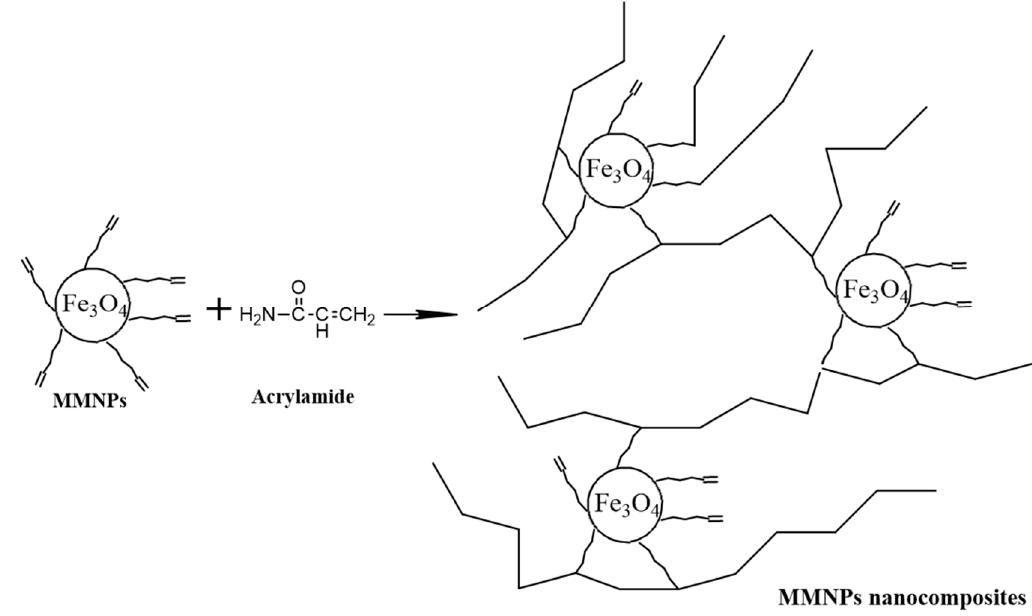
Figure 2. Preparation of polyacrylamide (PAA)/modified magnetic nanoparticles (MMNPs) nanocomposites.